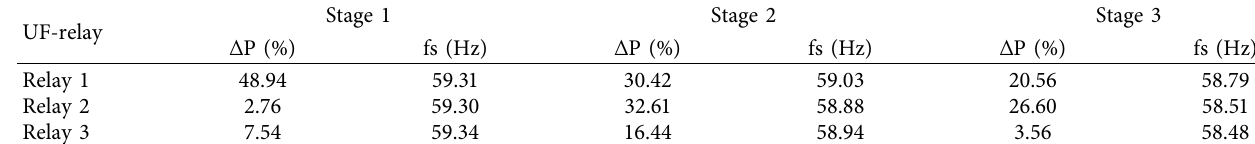
Table 3: Optimal settings of the UF-relays by using the IHS algorithm.